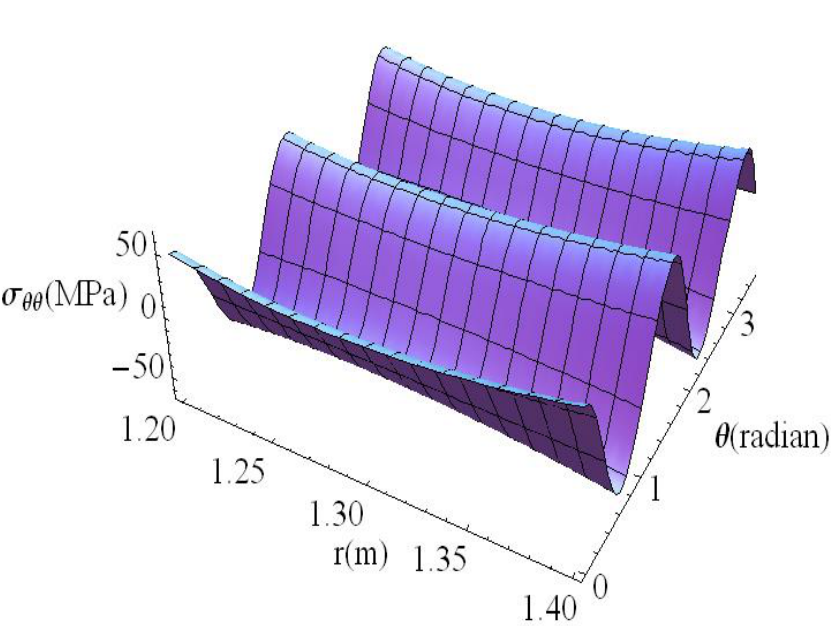
Figure 5. Circumferential stress at 𝛽 = 2